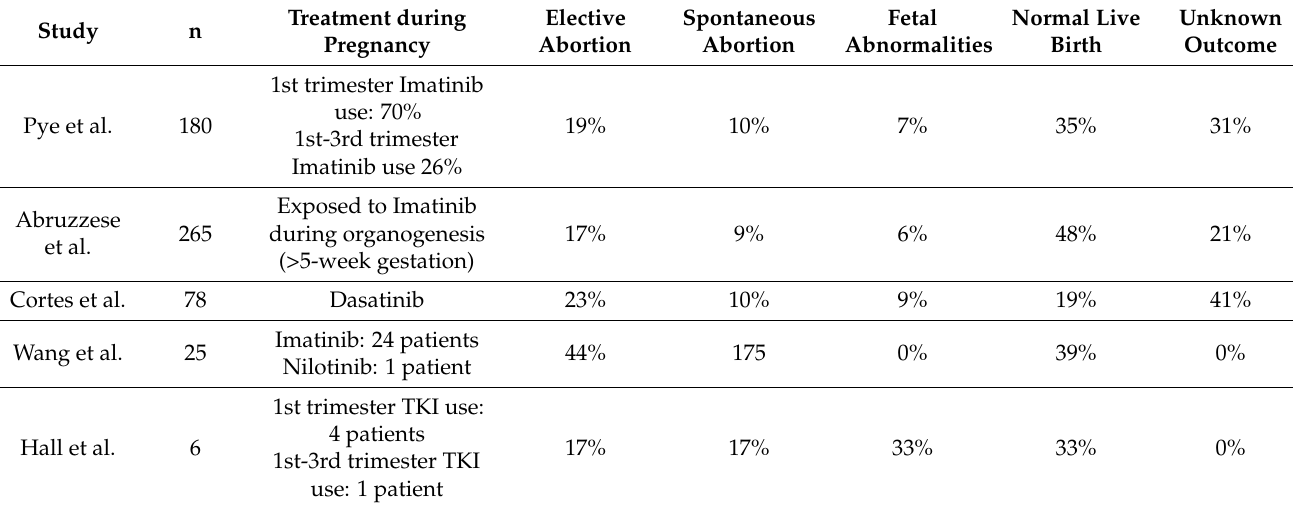
Table 1. Pregnancy outcomes in patients associated with TKI